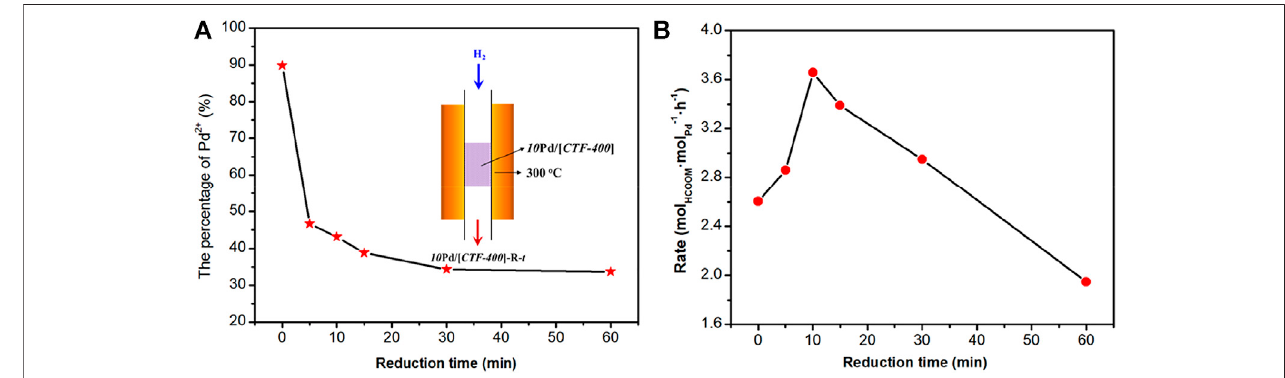
FIGURE 4 | Optimization of the ratio of Pd single-atoms to nanoparticles for the hydrogenation of carbon dioxide to formate. (A) Percentage of Pd 1 in 10 Pd/[ CTF- 400 ]-R- t samples. (B) Formate formation rate of 10 Pd/[ CTF-400 ]-R- t samples ( t = 0, 5, 10, 15, 30, and 60 min).